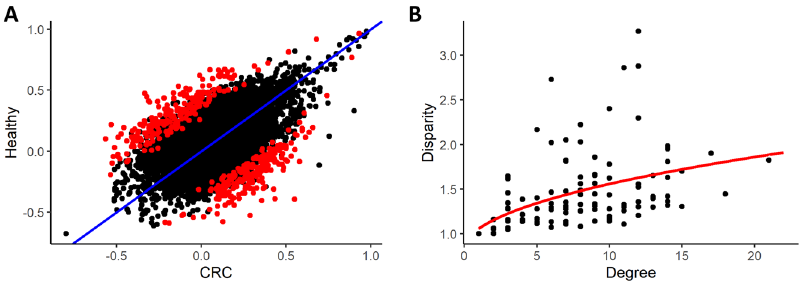
Figure 1: In panel (A), scatterplot of metabolites pair correlations in CRC subjects ( x axis) and healthy ( y axis) and identification of significant ( p -value cutoff 0.05 using a 1000-fold permutation test) pairs in red. In panel (B), scatterplot of the disparity measure ( y axis) in function of the nodes’ degree ( x axis) and the fitting curve y ∝ x 1 2 .